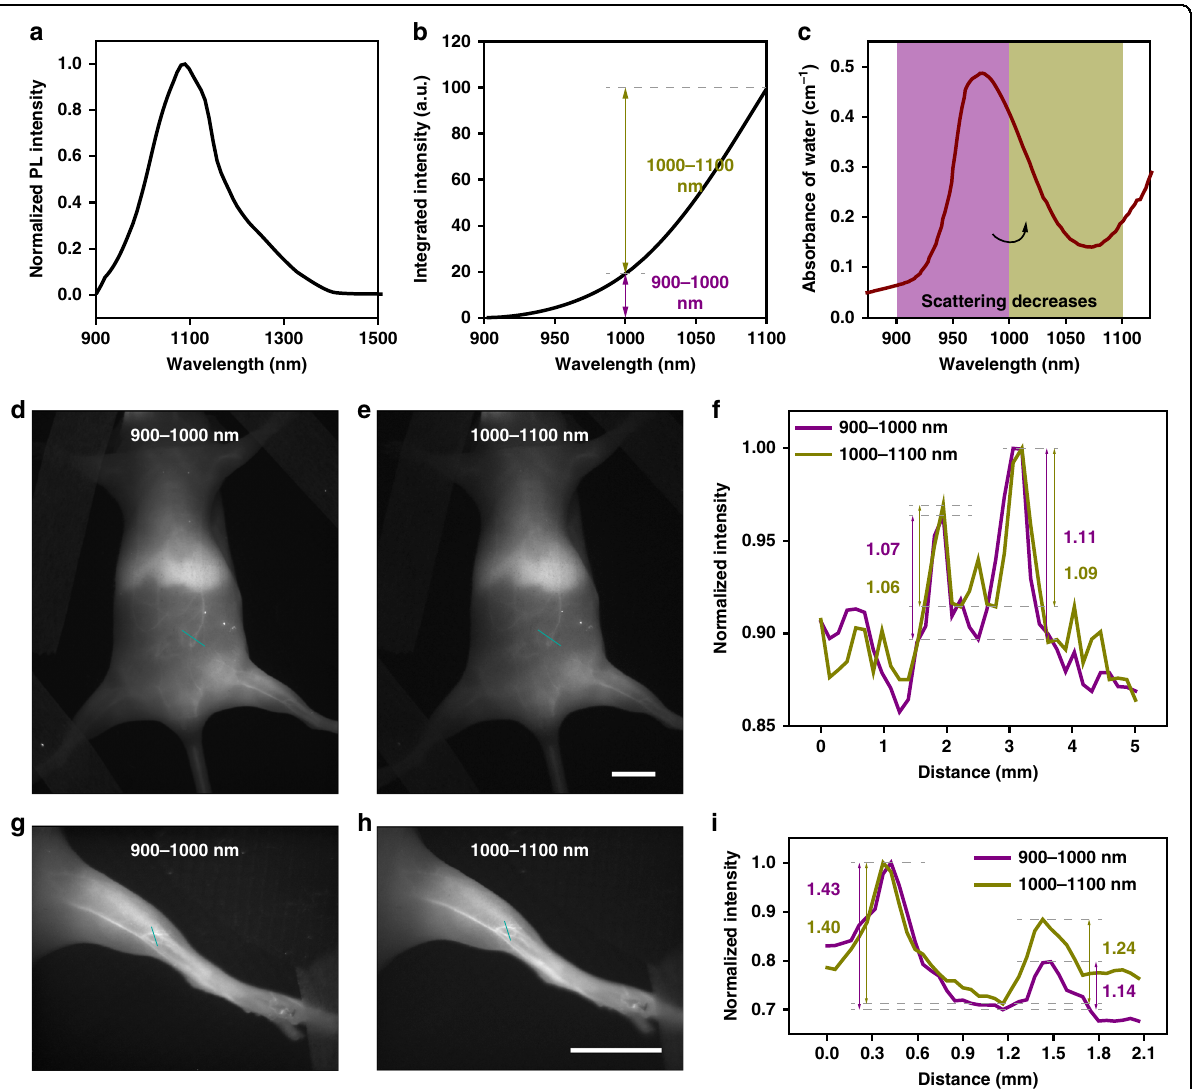
Fig. 3 Comparison of in vivo fl uorescence imaging of mice in 900 – 1000 and 1000 – 1100 nm. a The emission spectrum of PEGylated 1100-PbS/ CdS QDs in water. b The integrated emission intensity of PEGylated 1100-PbS/CdS QDs in water. The value of the ordinate represents the integrated emission intensity between 900 nm and the ordinate corresponding wavelength. The value difference on the ordinate represents the total emission intensity in the corresponding spectral (abscissa) range. c The absorbance of water within 800 – 1200 nm 38 . The whole-body imaging of the same mouse in ( d ) 900 – 1000 nm and ( e ) 1000 – 1100 nm. f Cross-sectional fl uorescence intensity pro fi les along the indigo lines of the blood vessel in ( d , e ). The numbers show the SBRs. The hind limb imaging of the same mouse in ( g ) 900 – 1000 nm and ( h ) 1000 – 1100 nm. i Cross-sectional fl uorescence intensity pro fi les along the indigo lines of the blood vessel in ( g , h ). The numbers show the SBRs. Scale bars: 10